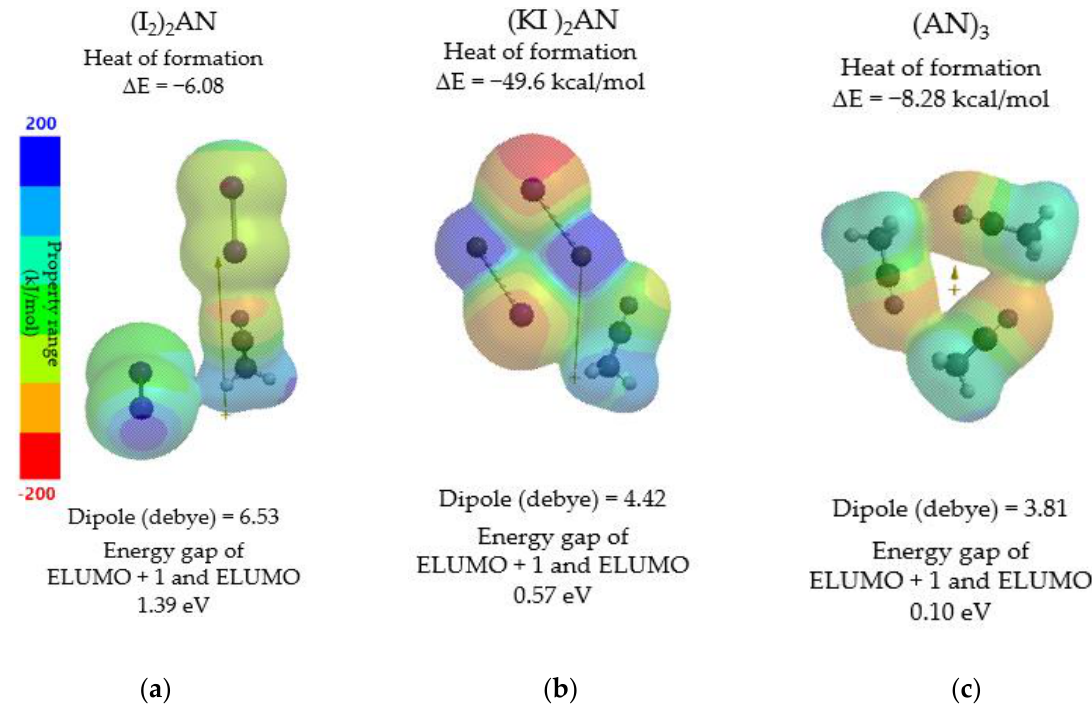
Figure 2. Electrostatic potential map (ESPM) with the heat of formation, dipole as measure of solubility and energy gap of energy of lowest unoccupied molecular orbital (ELUMO) + 1 and ELUMO as measure of conductivity: ( a ) (I 2 ) 2 AN; ( b ) (KI) 2 AN; ( c ) acetonitrile (AN) 3 . All vdW aggregates form exothermically, suggesting stability in AN. The most stable vdW aggregate of (KI) 2 AN (heat of formation is − 49.6 kcal / mol) gives a colorful ESPM, predicting further vdW aggregation with KI and I 2 in AN.